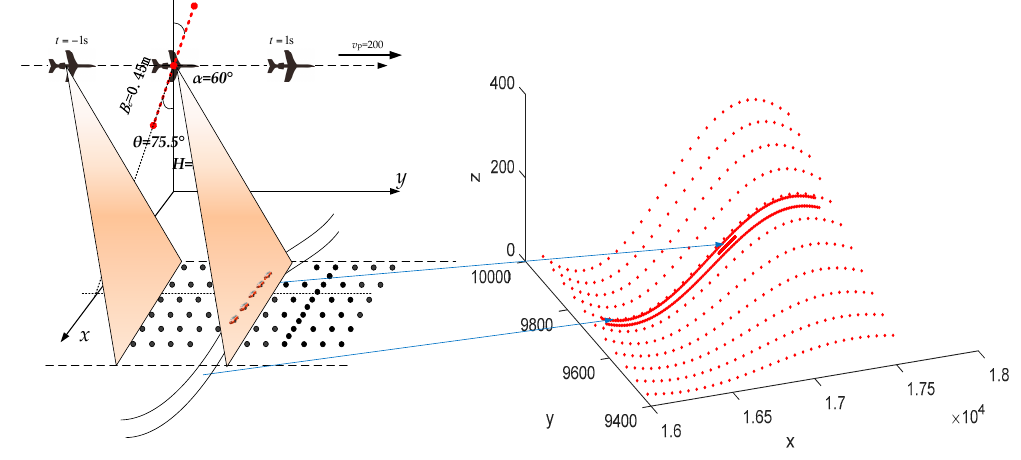
Figure 7. Ro-XTI-SAR system geometry and simulated targets. Table 1. The estimation results of each